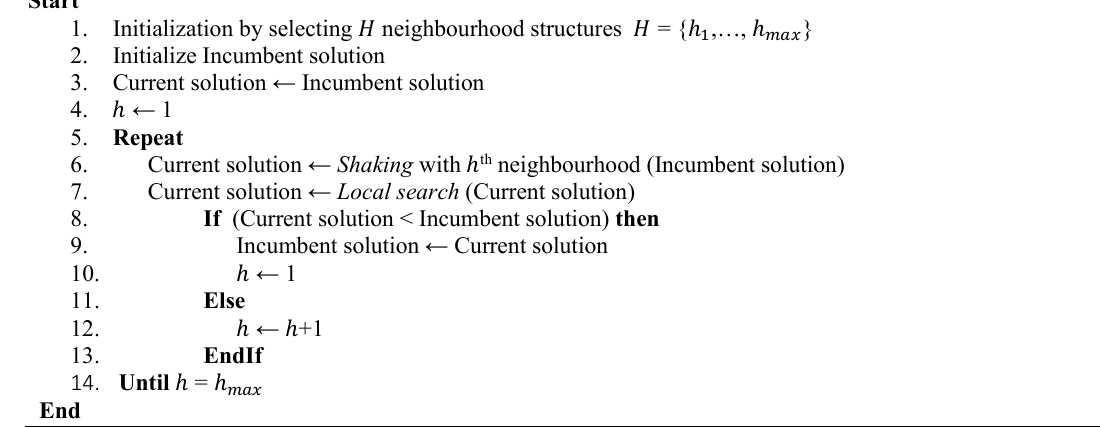
Algorithm 1: Basic concepts of Variable Neighbourhood